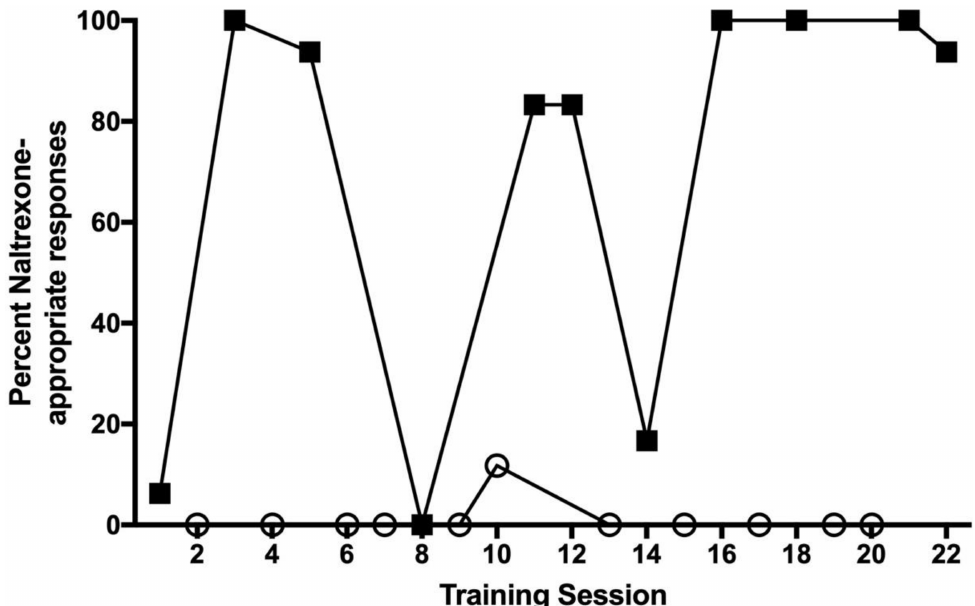
Figure 6. Reacquisition of NTX as a discriminative stimulus after 14 days sucrose access (25%). Data for NTX training sessions (filled squares) and saline training sessions (open circles) from a representa- tive subject are shown. NTX-appropriate responding is plotted as a function of training